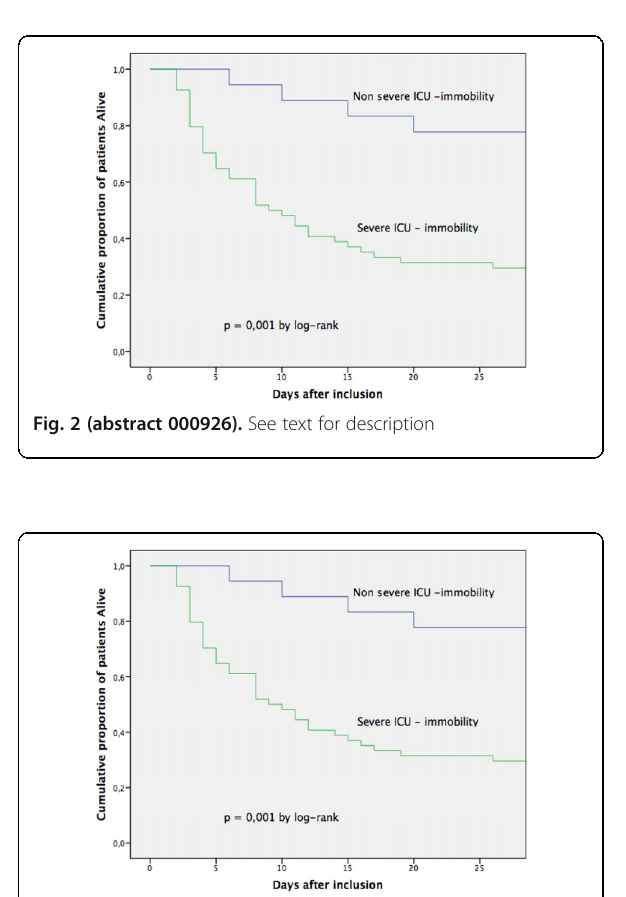
Fig. 3 (abstract 000926). See text for description